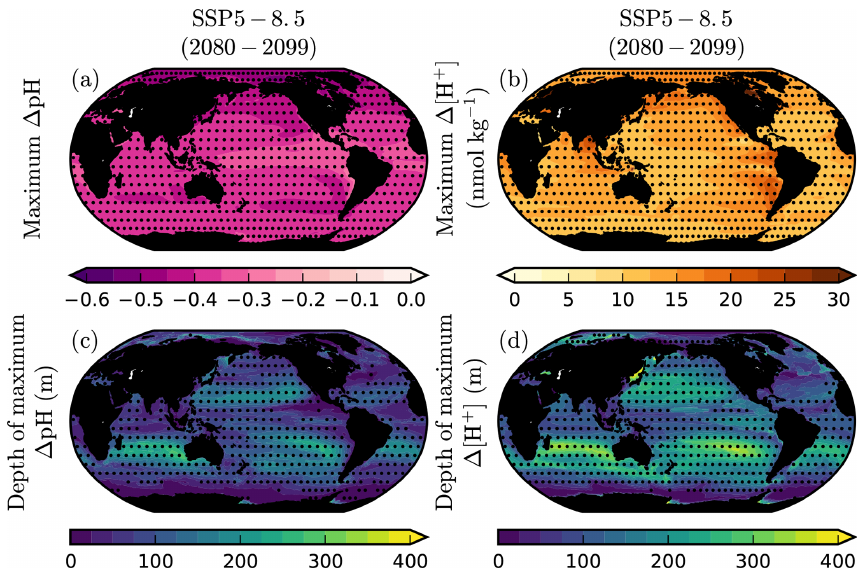
Figure 9. Magnitude and depth of maximum pH and [H + ] change under SSP5-8.5. The CMIP6 ensemble mean maximum change in (a) pH and (b) [H + ] in 2080–2099 of SSP5-8.5 relative to 1995–2014. The mean depth at which the maximum (c) pH and (d) [H + ] change is projected. Stippling designates robustness, as defined by the mean anomaly exceeding the inter-model SD.